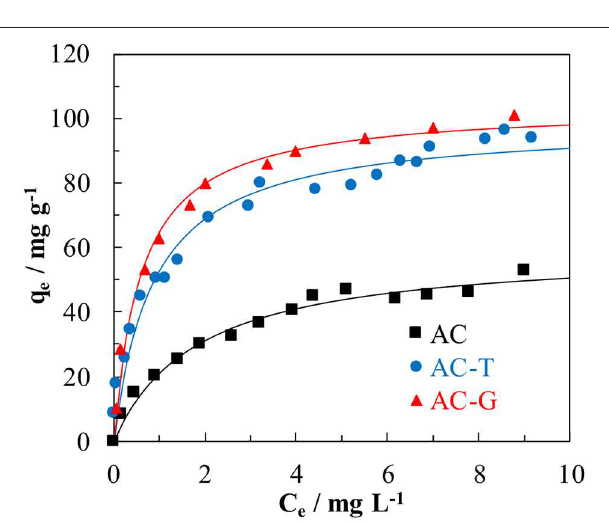
FIGURE 6 | Paracetamol adsorption isotherm at 25 ◦ C on AC, AC-T, and AC-G (dots: experimental data; line: Langmuir fitting).